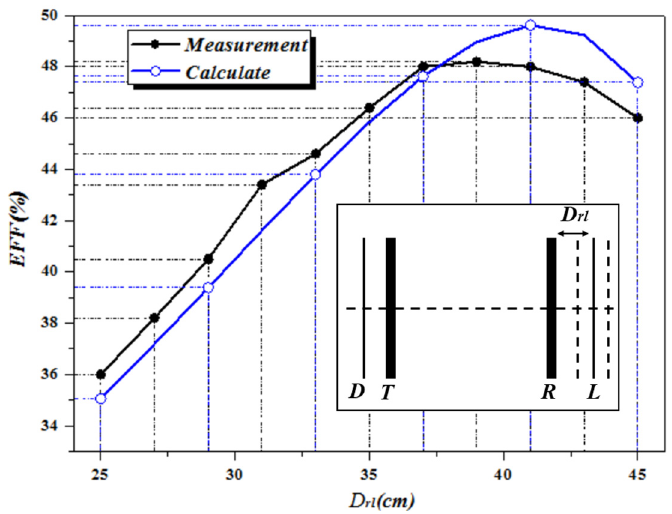
ffi ciency of WPT system without Figure 8. Calculation and simulation efficiency of WPT system without NMM. Figure 8. Calculation and simulation e